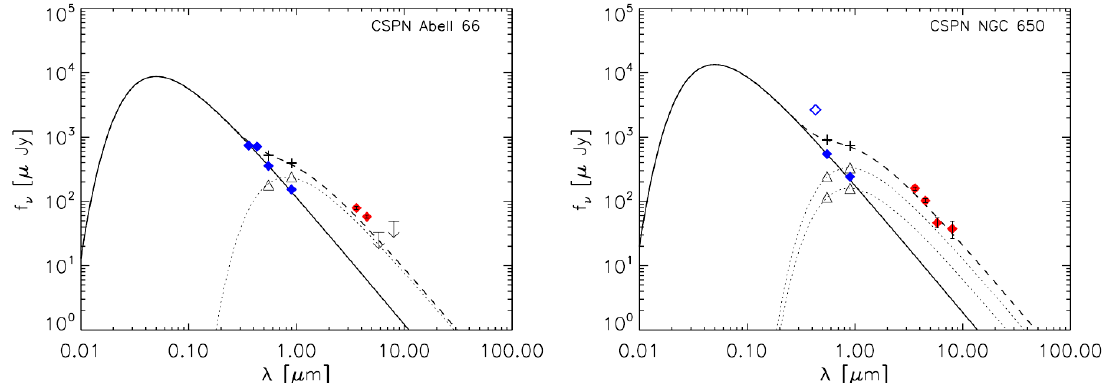
Figure 2. (adapted from [32]) Observed spectral-energy-distribution (SEDs) of two CSPNe with IR excesses caused by the companions’ photospheric emission. Blue and red symbols are extinction-corrected fluxes (IRAC & MIPS, in red, are extracted from the Spitzer images after removing the nebular background). The flux densities of the companion (triangles) and the sum of all components (plus symbols) are also shown. The solid (dotted) blackbody curve approximates the primary’s (companion’s) photospheric emission, and the dashed curves represent the sum of all emission. For NGC650, the (visual) companion itself is a binary (the B magnitude is possibly inaccurate, hence shown as open diamond) and may not be associated with the